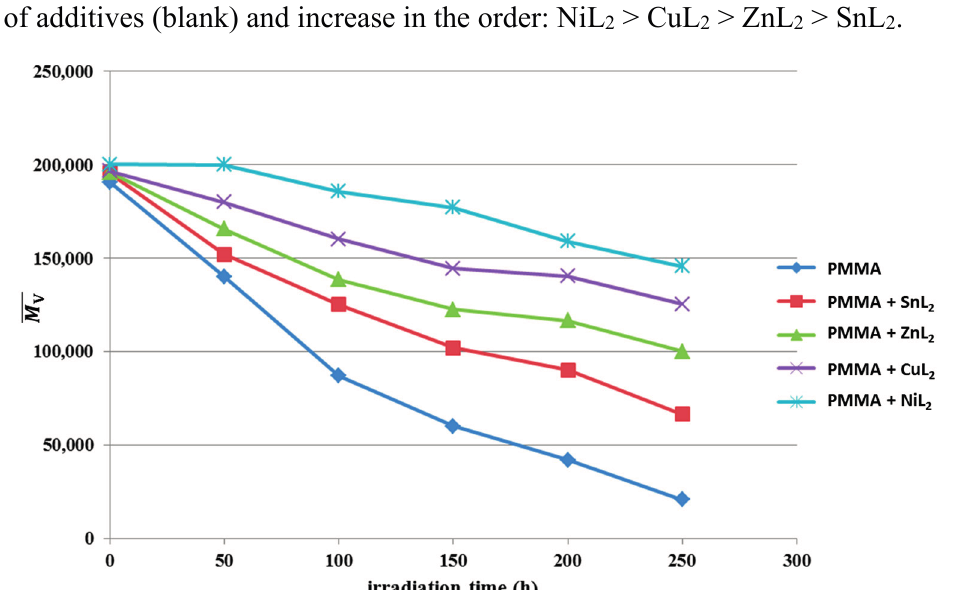
Figure 10. Changes in the viscosity average molecular weight (cid:4666)(cid:1839) PMMA films (40 μ m; control) and additives (0.5% by